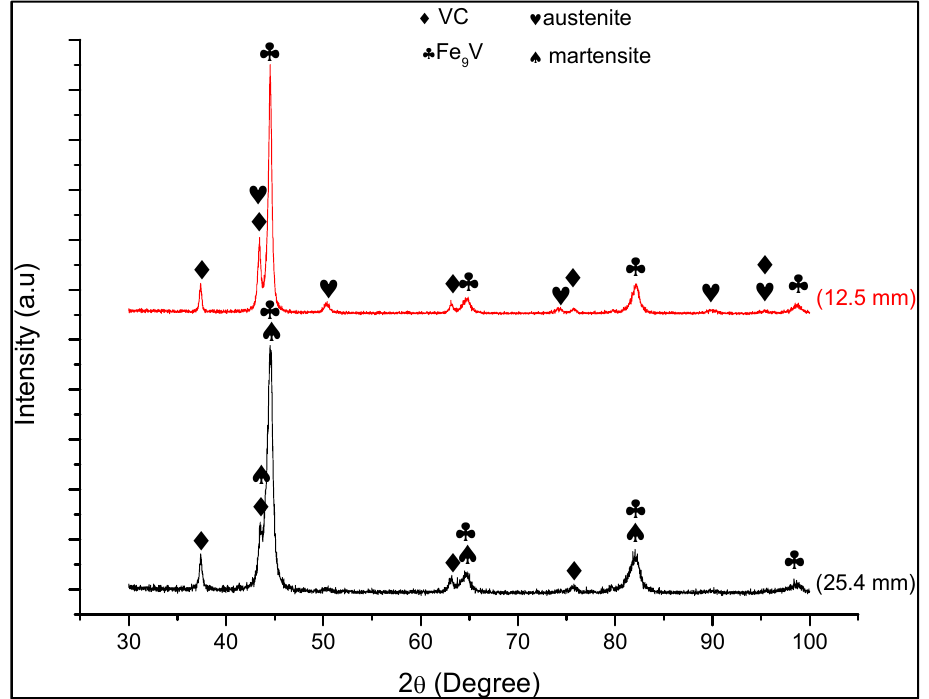
Figure 7. XRD analysis of the coatings deposited onto the substrates with thicknesses of 12.5 mm (red) and 25.4 mm (black).